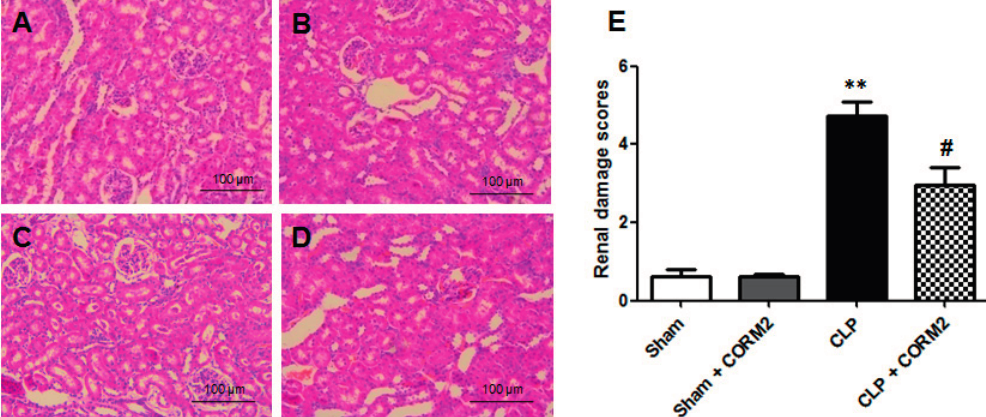
Figure 2. Carbon monoxide decreased renal injury by histopathological examination in septic rats. ( A – D ) The renal tissues were stained with hematoxylin and eosin (HE) and evaluated histopathological changes. ( A ) Sham group; ( B ) Sham + CORM-2 group; ( C ) CLP group; ( D ) CLP + CORM-2 group. Scale bar = 100 μ m; ( E ) Semi-quantitative